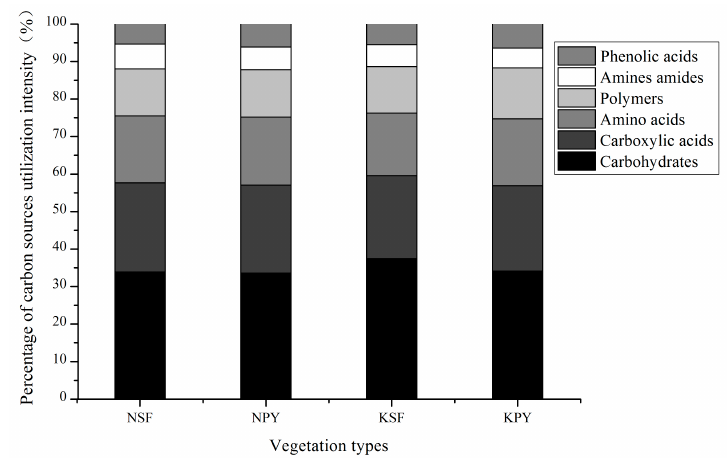
Figure 4. The utilization percentages of six categories of carbon substrates under different vegetation types.